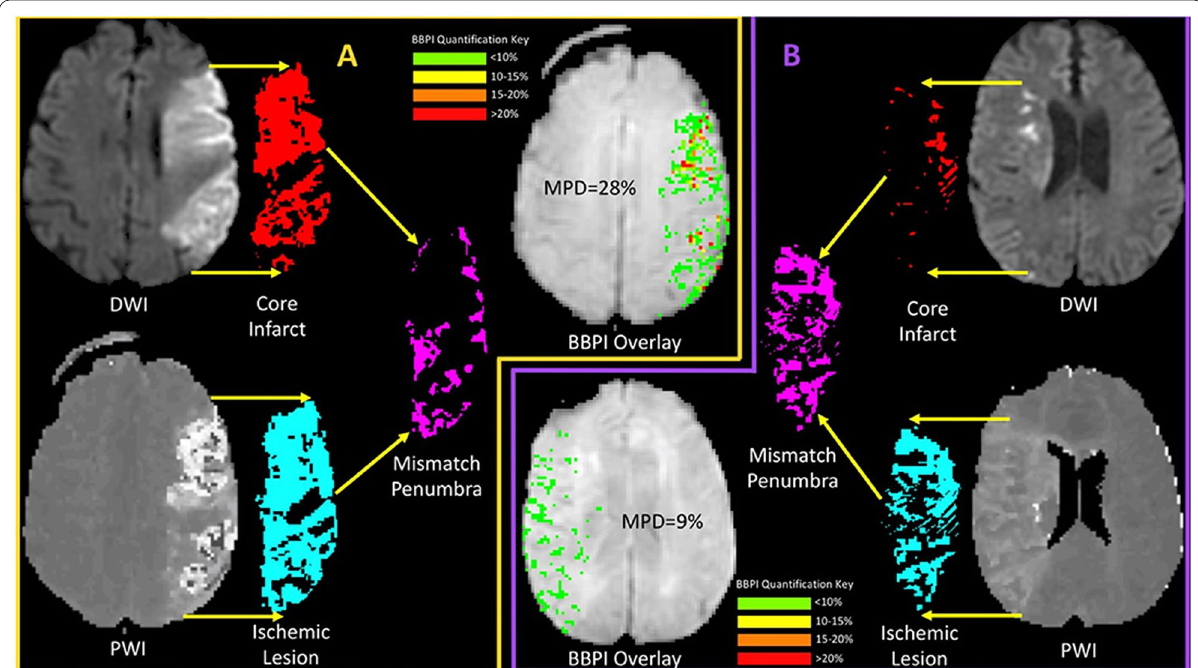
Fig. 4 Examples of blood–brain barrier permeability images using dynamic susceptibility contrast-enhanced perfusion-weighted imaging (DSC-PWI) showing the relative increase of BBB permeability in the area of ischemia compared to the corresponding area of the unaffected hemisphere (upper right image, respectively lower left image in ( a, b )) [108]. Figure reproduced according to the Creative Commons Attribution (CC BY) license from: Heidari et al. (2020). Copyright © 2020 Heidari, Blayney, Butler, Hitomi, Luby and